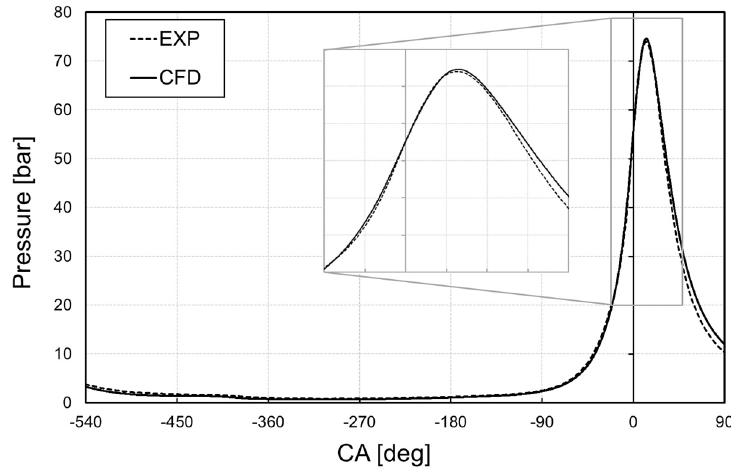
Figure 5. Results of the numerical model calibration: comparison between simulated and measured in-cylinder pressure in full power conditions.